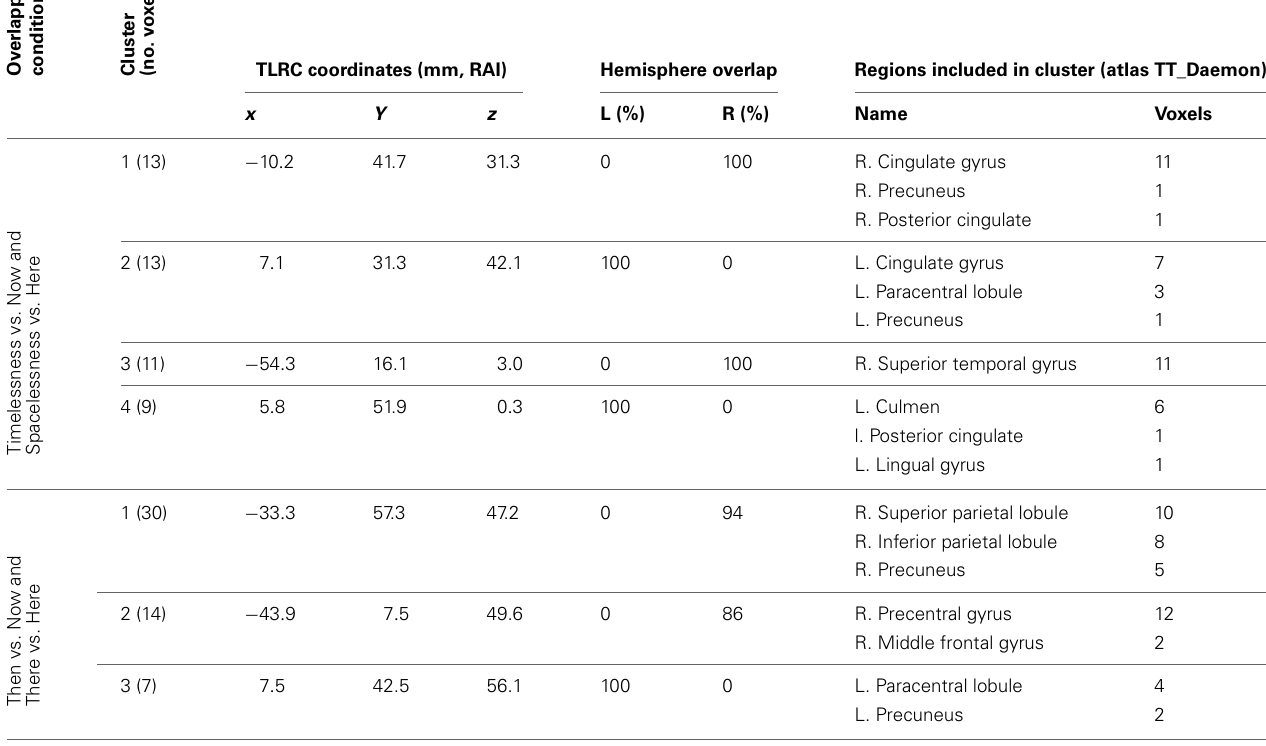
Table 3 | Beamforming solutions for the overlapping contrasts between Timelessness/Spacelessness and Then/There in the theta (4–8Hz) frequency band ( n = 11).